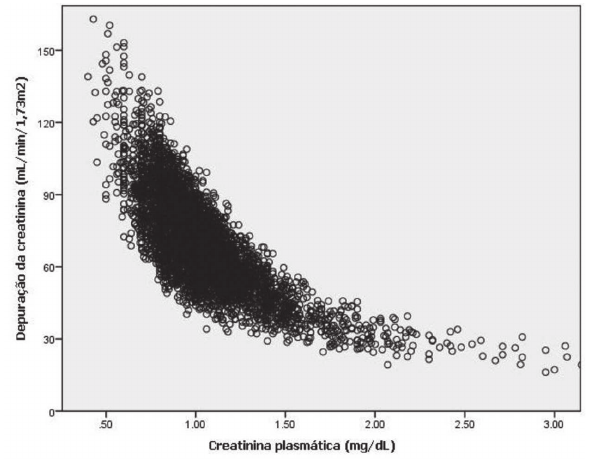
Fig. 3 - Gráfico por dispersão com os valores possíveis de DCEe/ 1,73m 2 para o mesmo valor de CrP